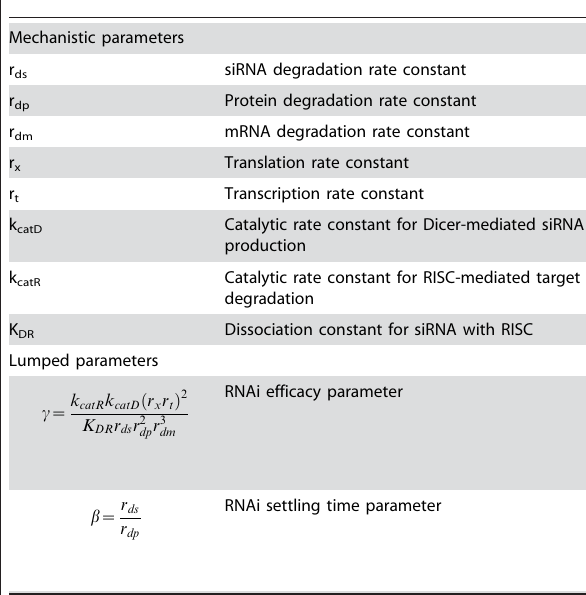
Table 1. Parameters of RNAi model.